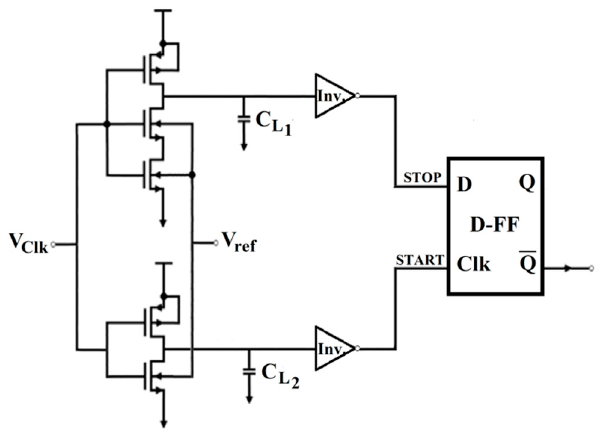
Figure 15. The detection circuit for calibration of the first proposed VTC.